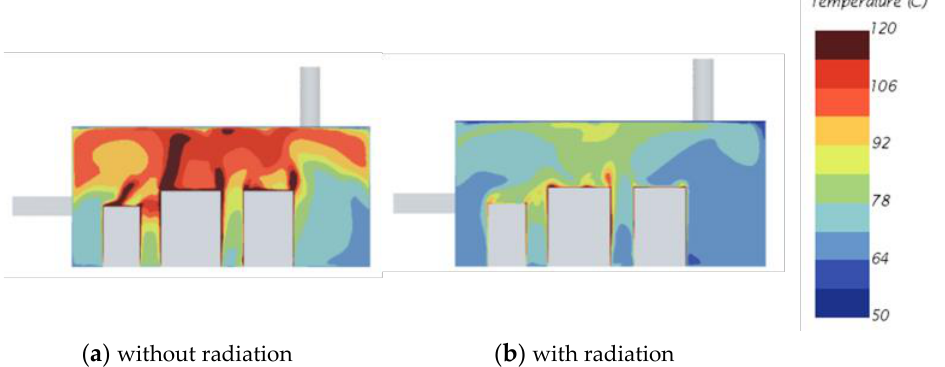
Figure 9. Cross-sectional view (centered on Outlet 1) of the air temperature for the cockpit underfloor equipment bay (Configuration 1).